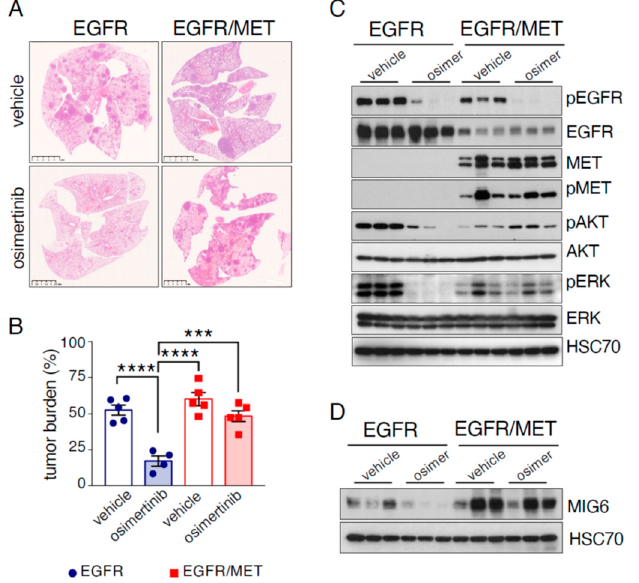
Figure 3. EGFR/MET-driven tumors are resistant to osimertinib. ( A ) Hematoxylin and eosin staining of whole lungs from EGFR mice treated with vehicle ( n = 5) or osimertinib ( n = 4) and EGFR/MET mice treated with vehicle ( n = 5) or osimertinib ( n = 5) for 4 weeks. Scale bar, 5 mm. ( B ) Tumor burden from same samples as described in ( A ). Values are the mean ±SEM; *** p ≤ 0.001, **** p ≤ 0.0001 (one-way ANOVA followed by Tukey post hoc test). ( C ) Immunoblotting of the indicated proteins in lung tumors from EGFR and EGFR/MET mice treated with vehicle or osimertinib. ( D ) Immunoblotting of the indicated proteins in lungs tumors from EGFR and EGFR/MET mice treated as in ( C ).